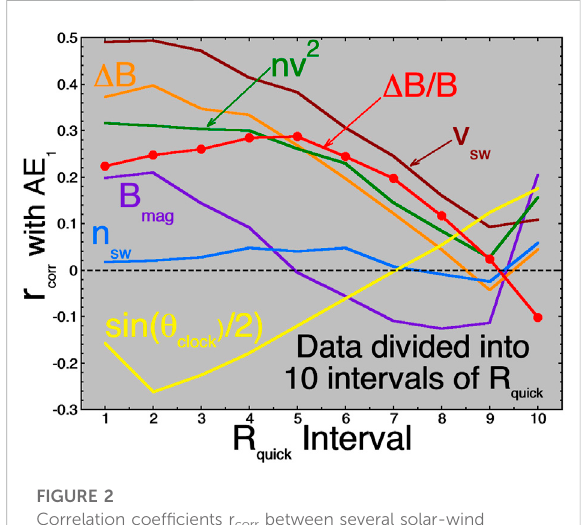
FIGURE 2 Correlation coef fi cients r corr between several